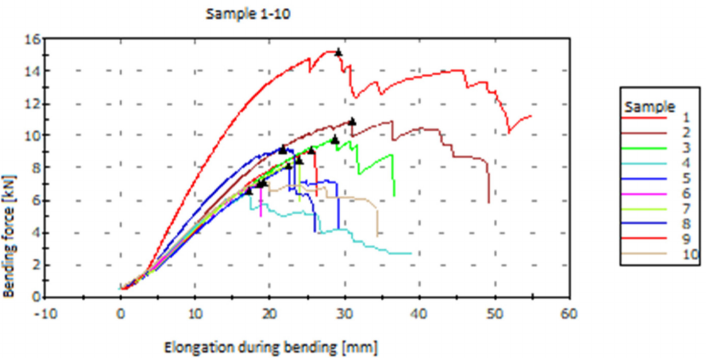
Figure 11. Results of the bending strength test for pine wood elements obtained during the test at the INSTRON